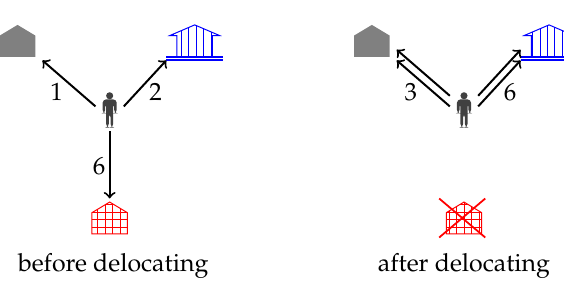
Figure 2. Proportional reassignment of